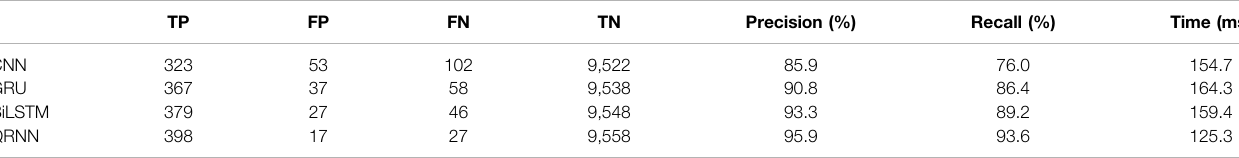
TABLE 3 | TP, FP, FN, TN value, precision, recall and running time of each